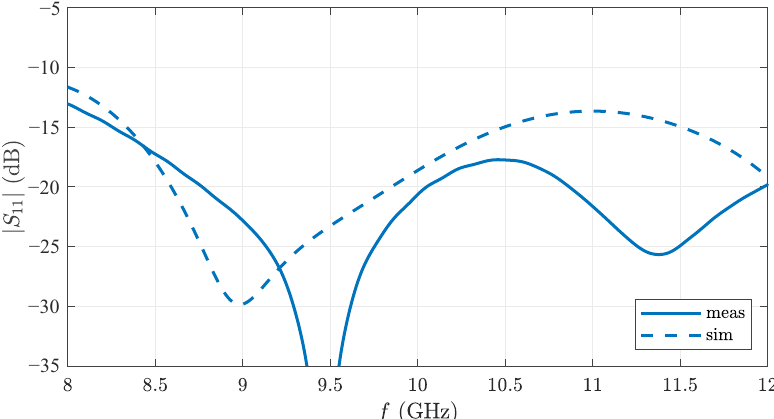
Figure 9. Simulated and measured S-parameters of the proposed Vivaldi antenna.